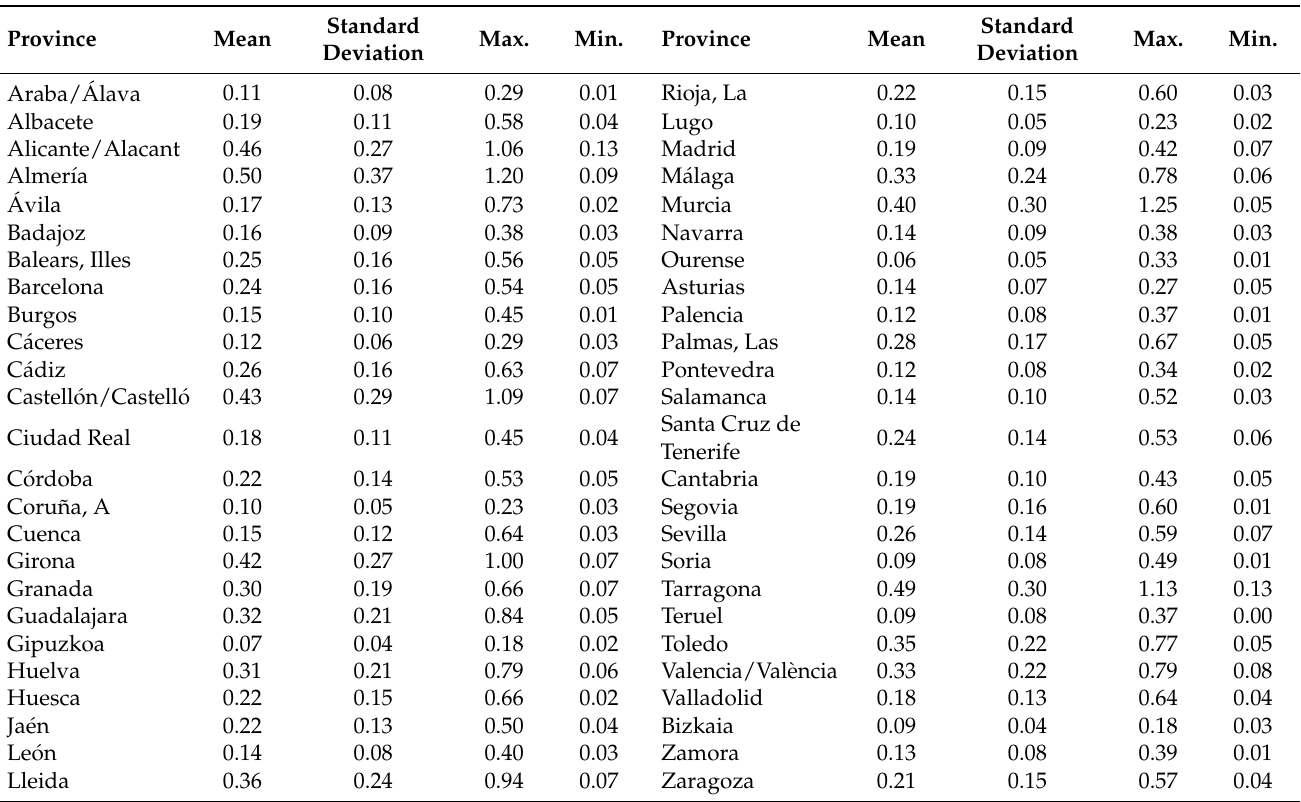
Table 1. Provincial foreclosure rates: Descriptive